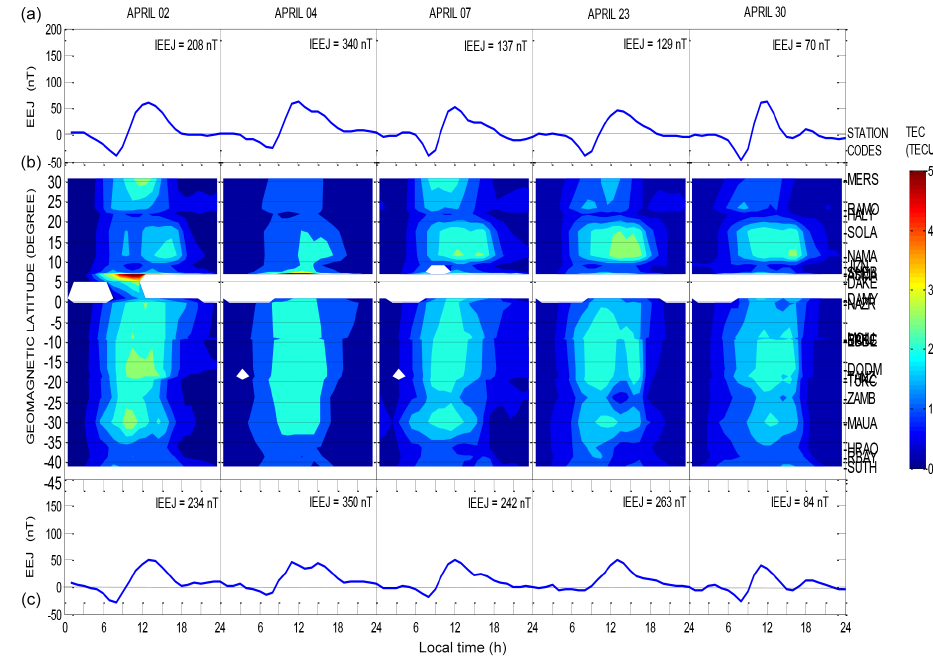
Figure 5. The TEC magnitudes of the quietest days, equatorial electrojet (EEJ) strength, and integrated EEJ strength in April.